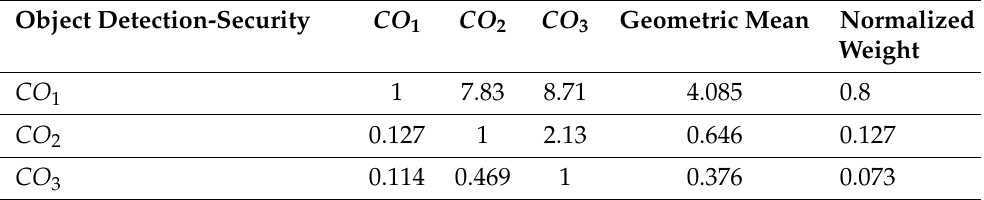
Table 9. Comparison between suitable components for object detection with respect to security.